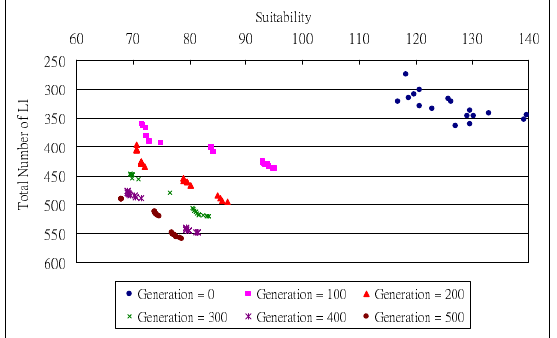
Fig. 5. The Pareto fronts derived by the proposed approach for the exponential dataset with different generations